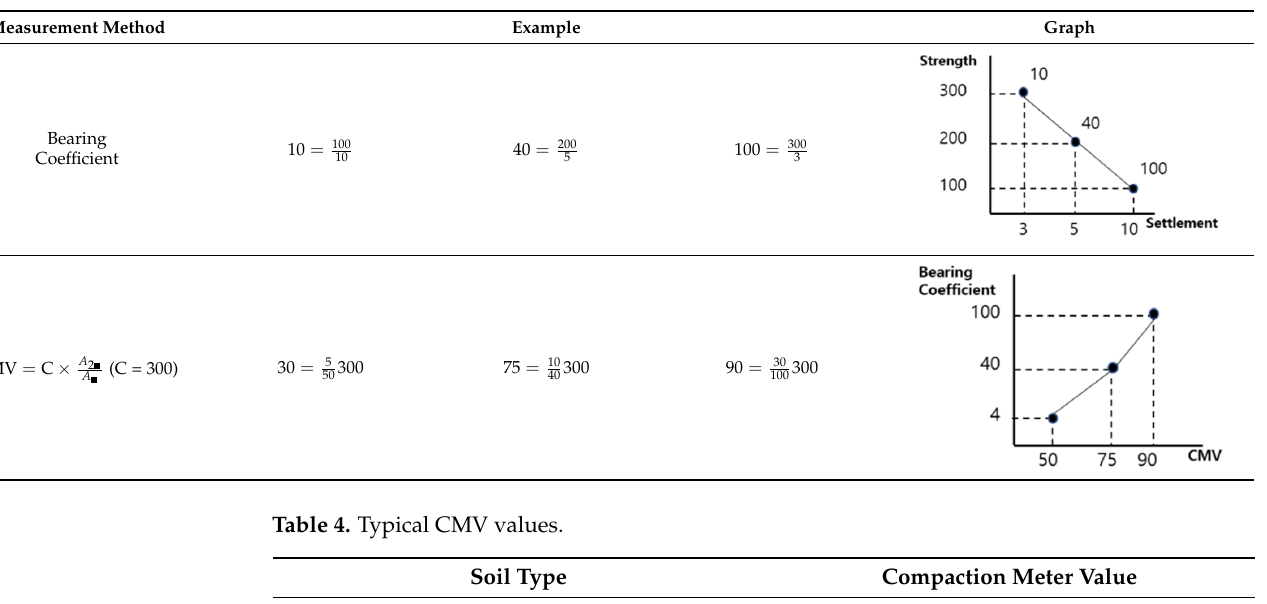
Table 3. A general correlation between the CMV and the bearing coefficient.